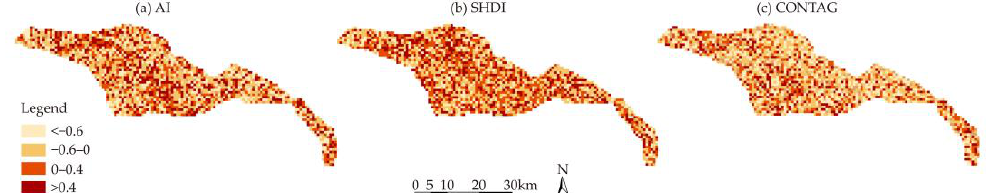
Figure 10. Spatial distribution of correlation during 1967 – 2018 between the habitat quality and the indicators of landscape pattern: ( a ) AI; ( b ) SHDI; and ( c ) CONTAG.